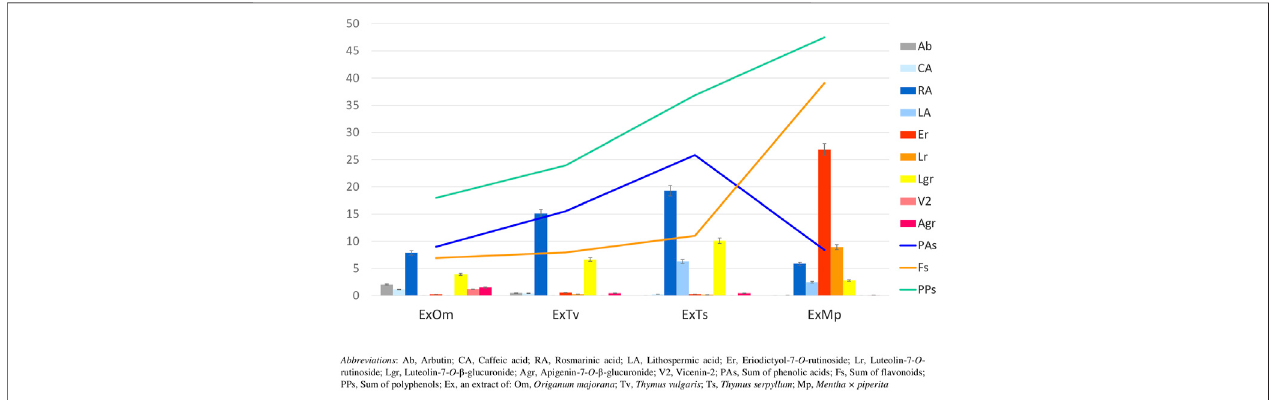
FIGURE1| Contentofpolyphenols (%)indriedaqueousextracts ofmarjoram (ExOm),thyme(ExTv),wildthyme (ExTs), andpeppermint (ExMp). Thelinear graphs show the sum of labeled compounds from each polyphenol group. The bar graphs represent individual polyphenol compounds.